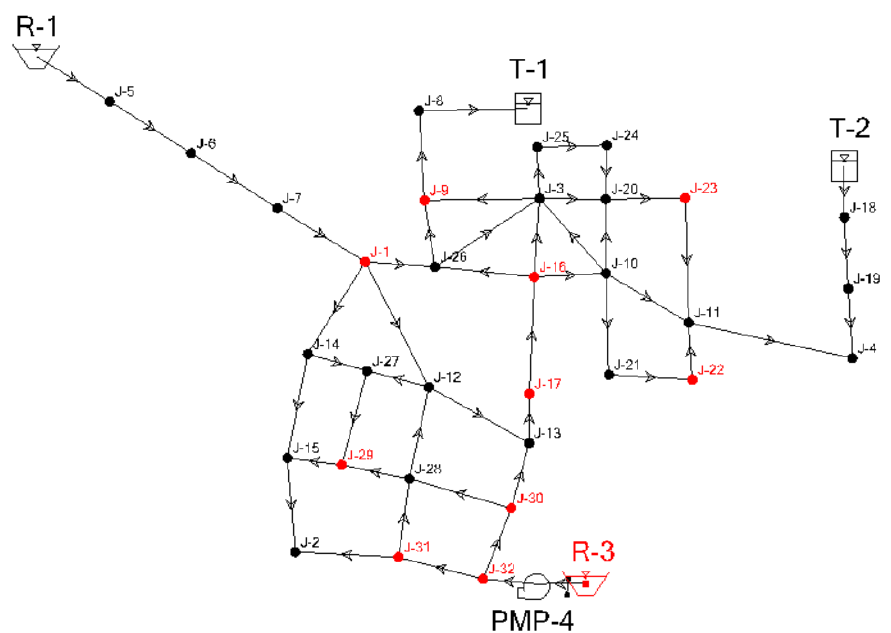
Figure 2. The eleven nodes (marked as red) with the highest frequency of appearance in the 24 sce- narios for Ο 2 .